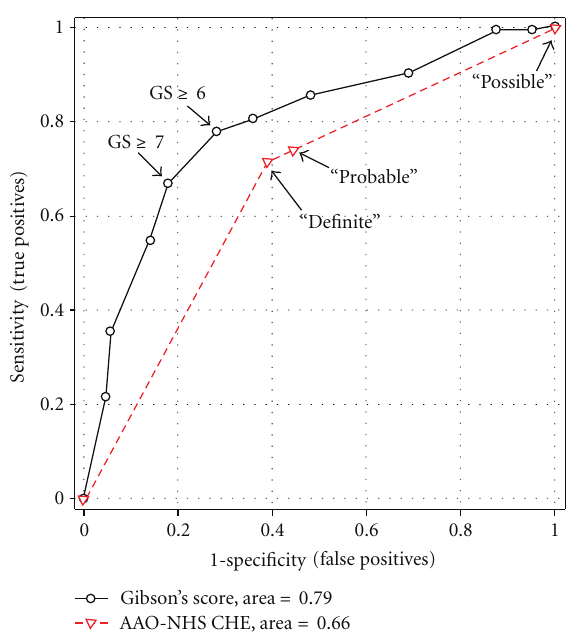
Figure 3: A receiver operating characteristic (ROC) curve of the Gibson score test showing 11 cuto ff points (right to left from 0 to 10) and that of the AAO-HNS CHE test showing 3 cuto ff points (“possible,” “probable,” and “definite”).